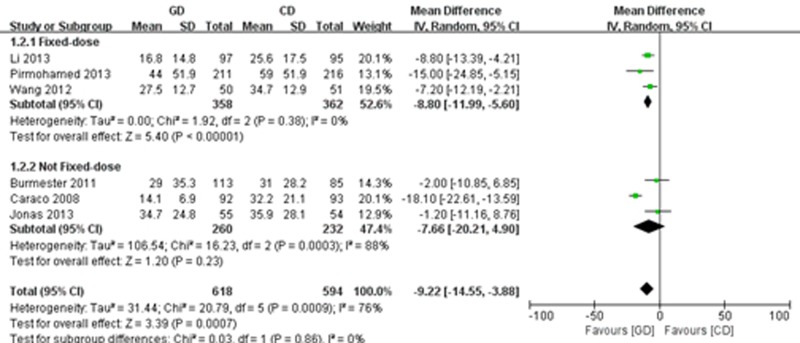
Forest plot of the time to maintenance dose.